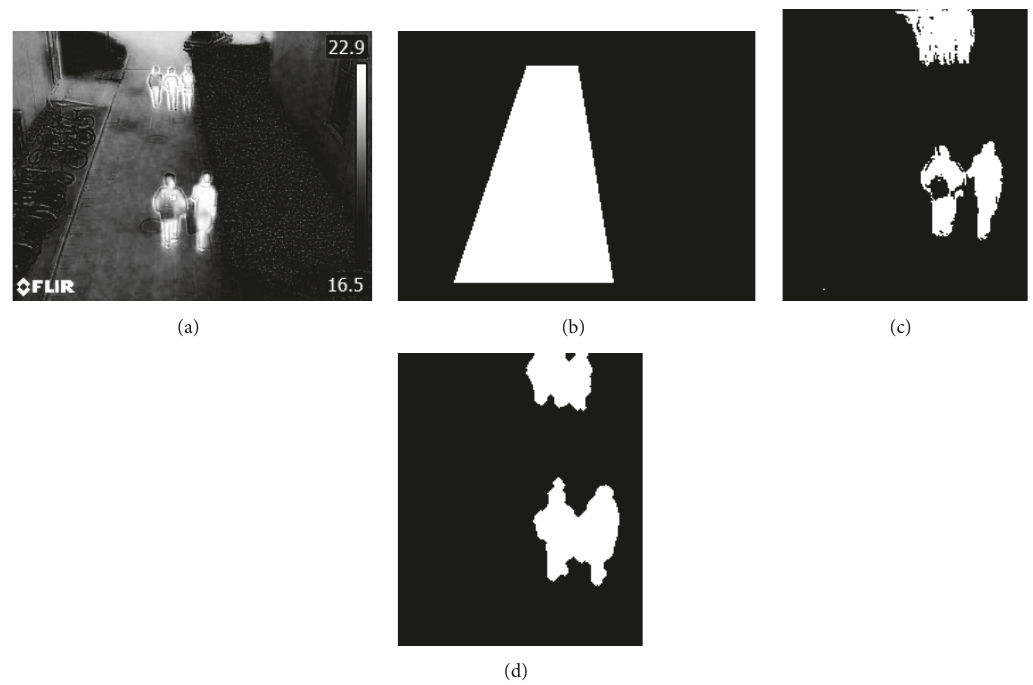
(2) Number of edge points 𝐸𝑃 𝑘 , which is the weighted sum of pixels on the boundaries of the